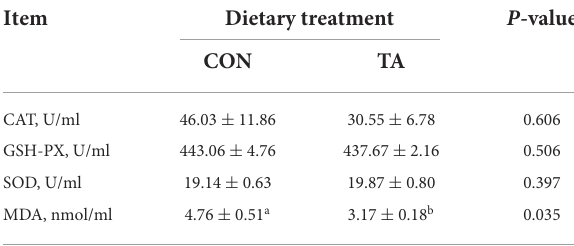
TABLE 2 The antioxidant capacity of serum in weaning piglets 1